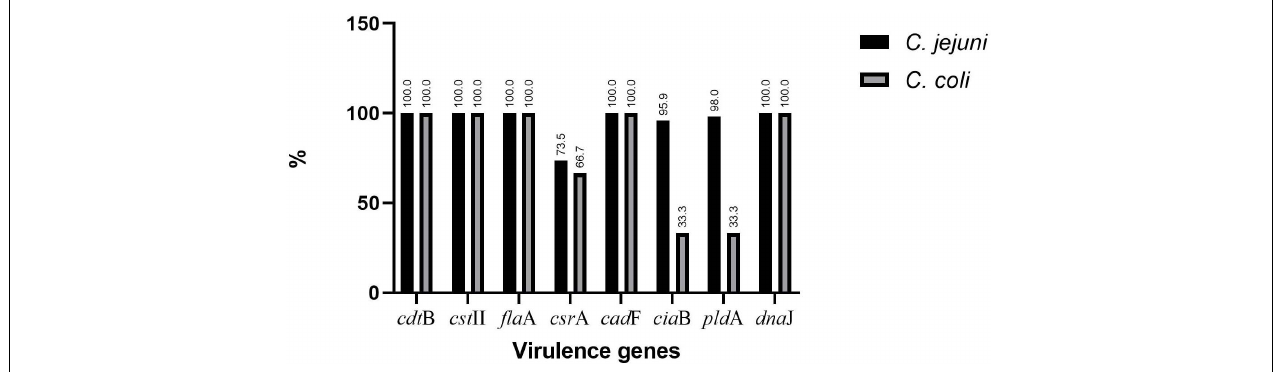
FIGURE 2 | Distribution of virulence genes in Campylobacter jejuni and Campylobacter coli .